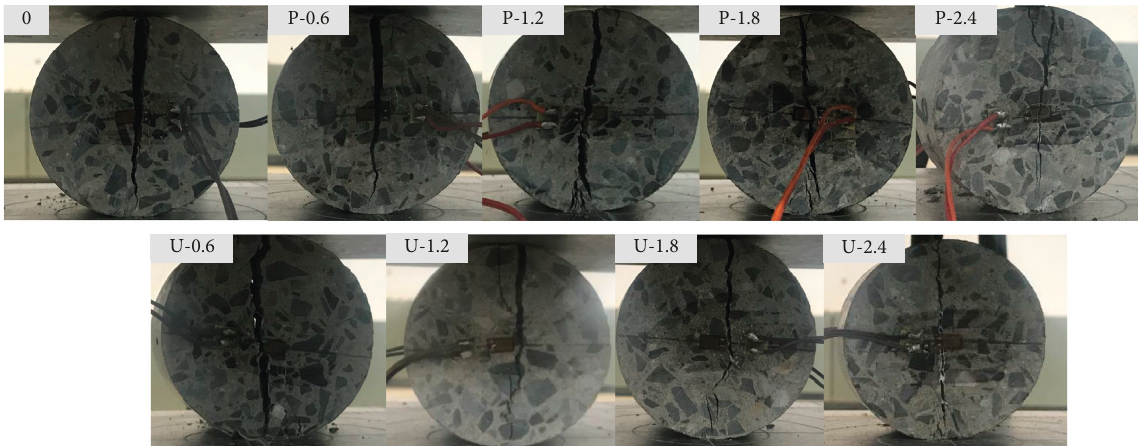
Figure 16: Static collapse behavior of each group of concrete.